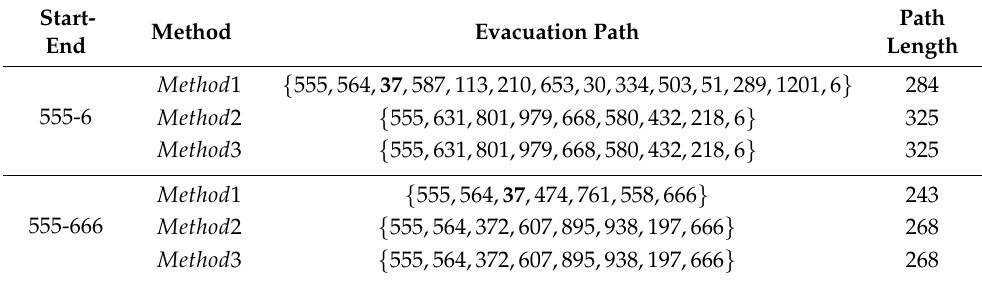
Table 10. Optimization results of the shortest evacuation